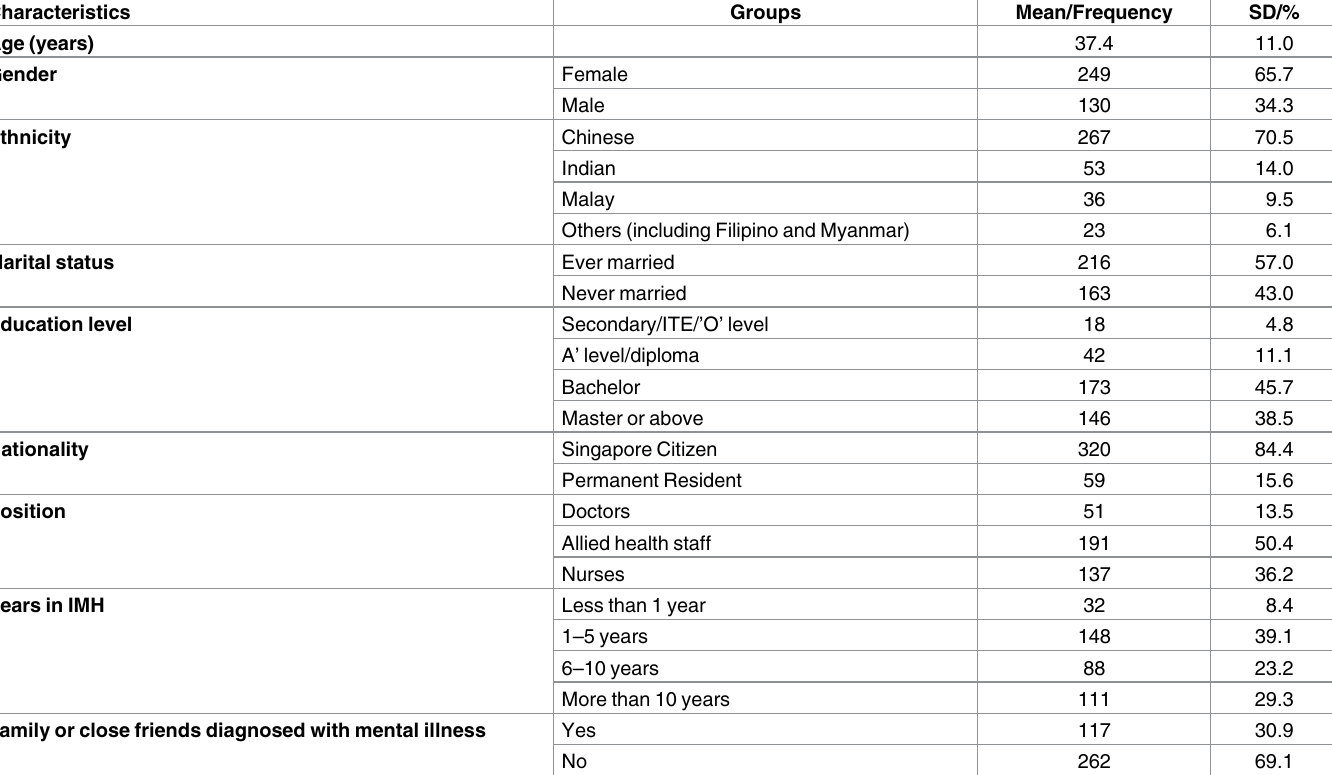
Table 1. Socio-demographic characteristics of the sample (n =